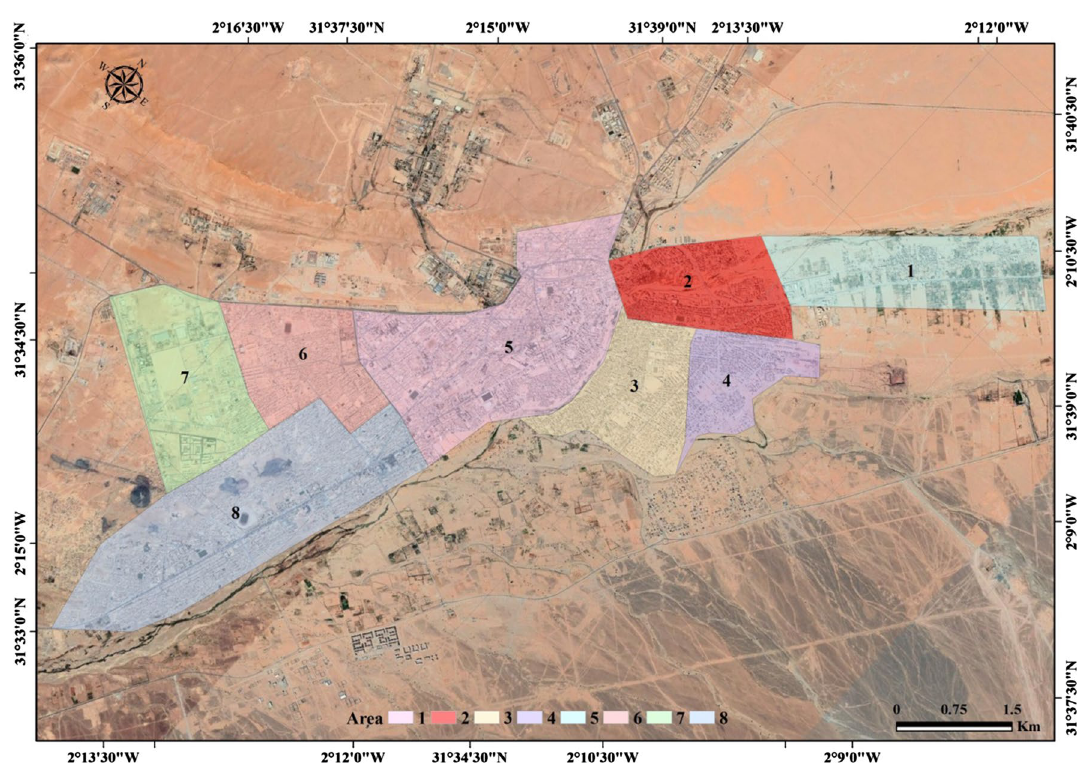
Fig. 5 The distribution areas of Bechar